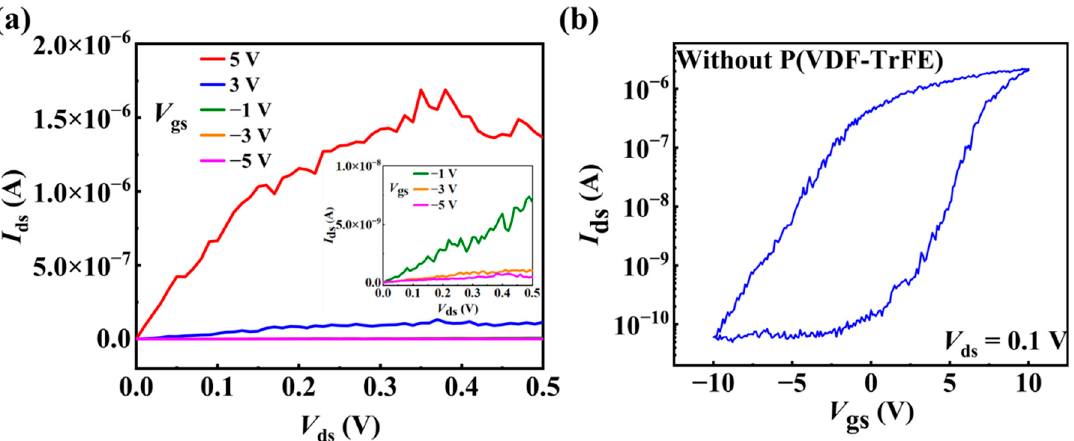
Figure 3. Electronical characteristics of the as-fabricated back-gate device (the pristine device). ( a ) The output characteristic curves measured under different gate voltages. The inset shows the data at low current level. ( b ) The transfer characteristic curve measured at V ds = 0.1 V.